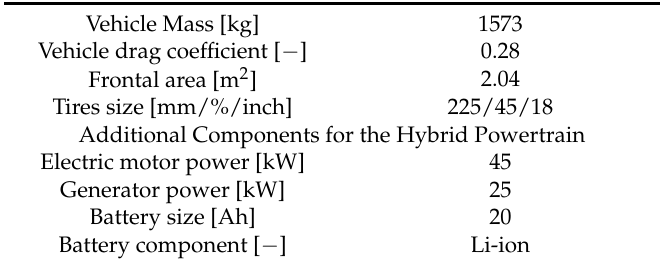
Table 5. Vehicle